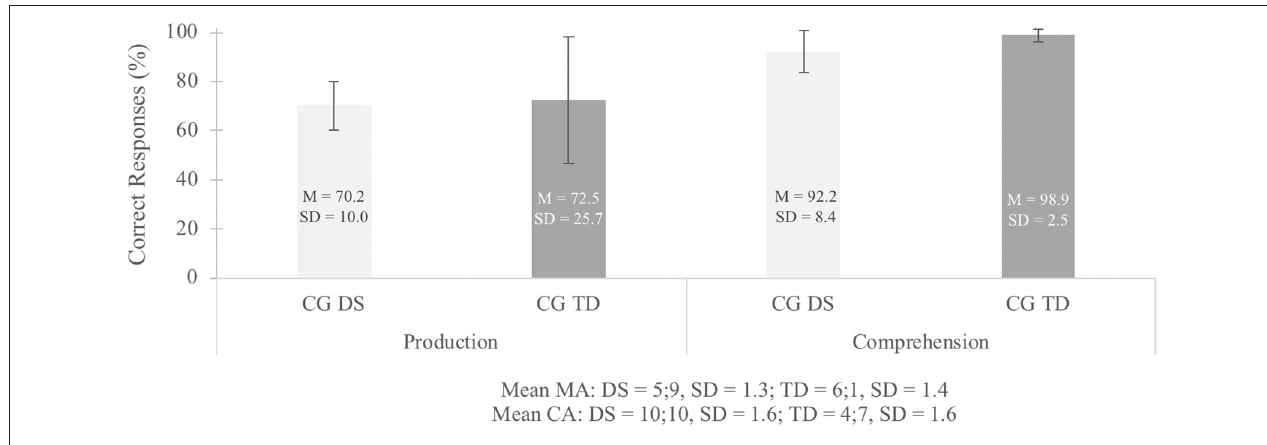
FIGURE 3 | Subjunctive production and comprehension for a subgroup of five participants per group.